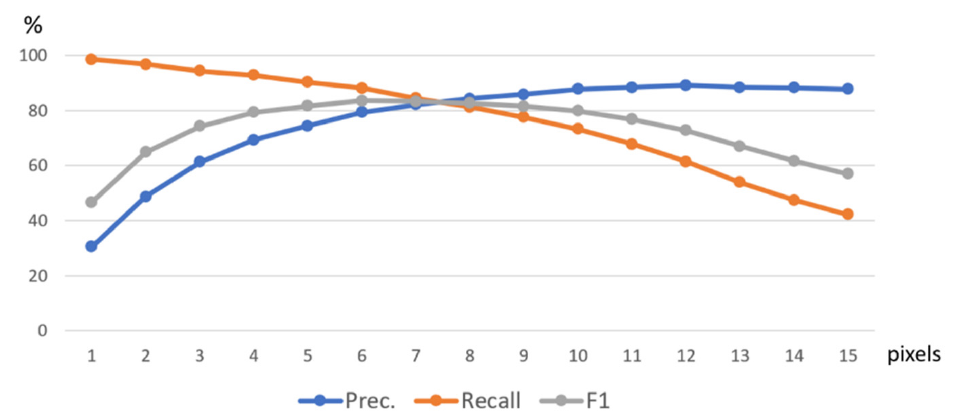
Figure 15. Treading curves of precision, recall, and F1 score under different area thresholds (in pix ‐ els). Increasing precision is accompanied by decreasing